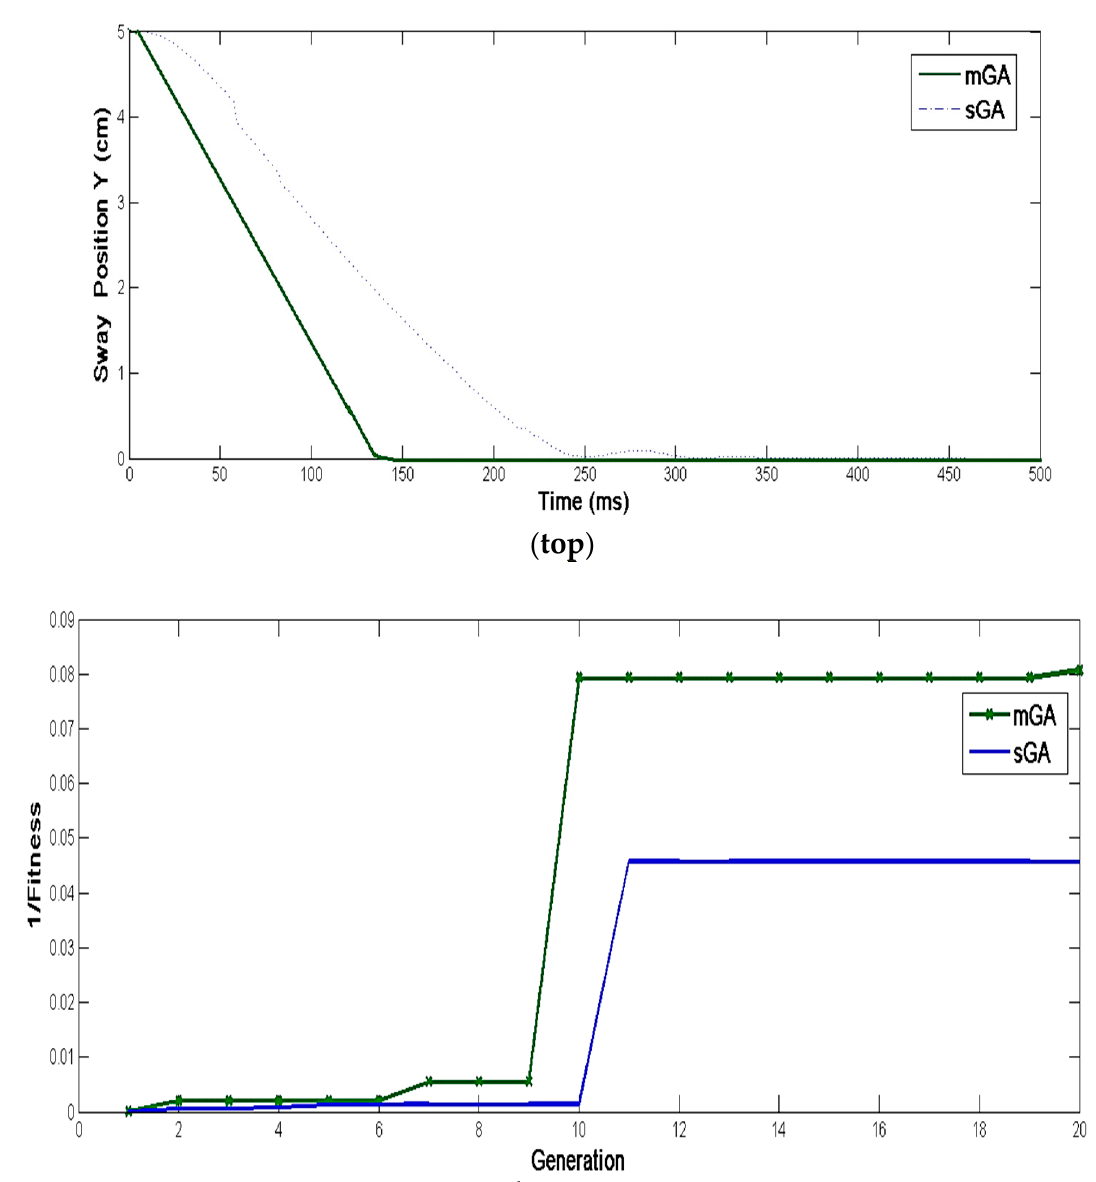
Figure 5. ( Top ) Surge—position control; ( bottom ) improved GA (mGA) versus standard GA (sGA) fitness functions.